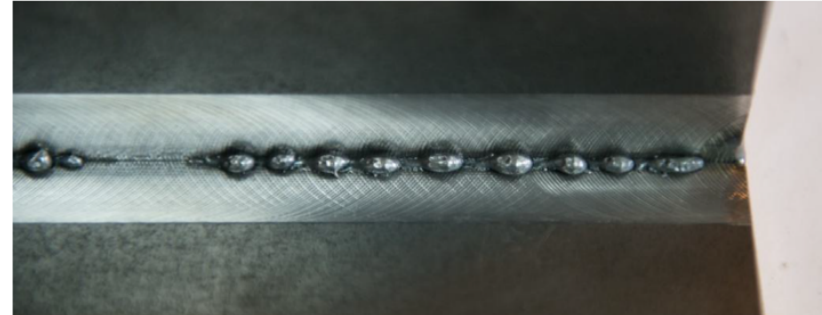
Figure 6. Single ‐ sided T ‐ joint with excessive penetration on the root side.